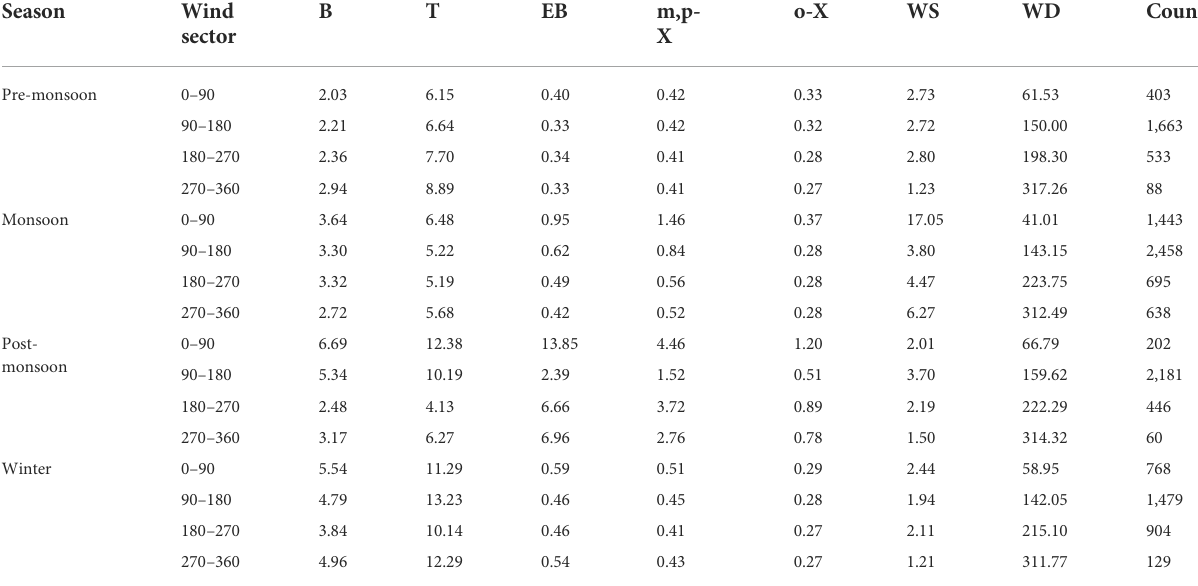
TABLE 2 Seasonal mean concentrations of BTEX components, wind speed, and direction in the four directional sectors of